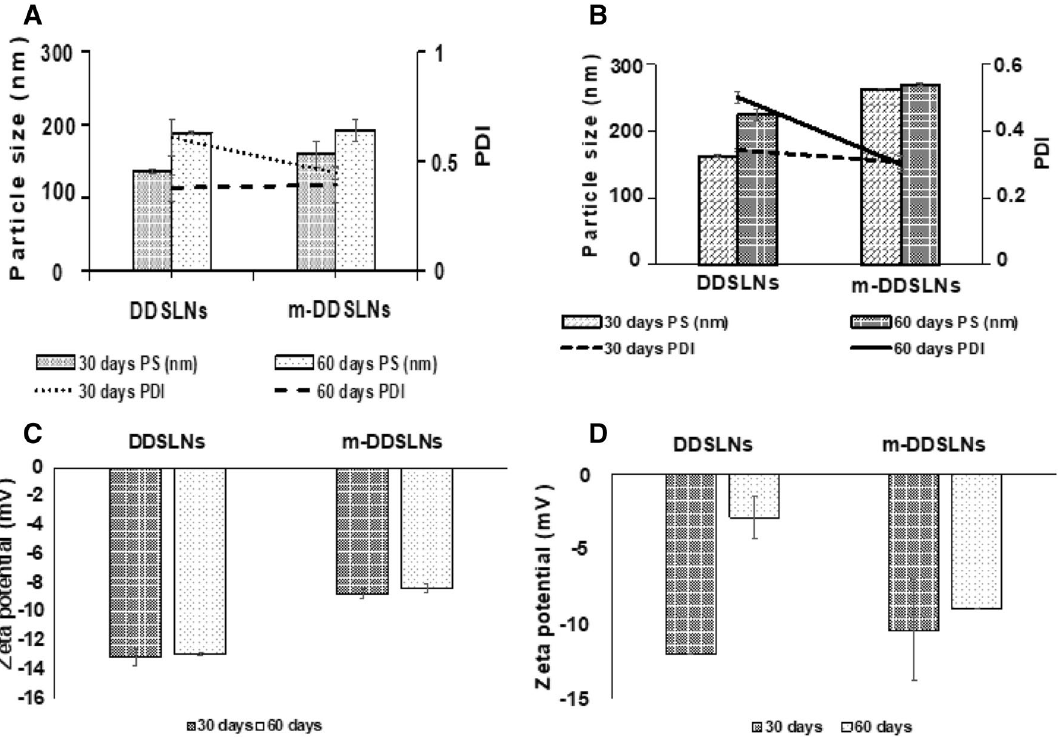
Figure 3. ( a ) Temperature dependent stability at 4 °C for 60 days. ( b ) Temperature dependent stability at 25 °C for 60 days. ( c ) Zeta potential (mV) at 4 °C for 60 days. ( d ) Zeta potential (mV) at 25 °C for 60 day. Results are presented as mean ± standard deviation, (n = 3).